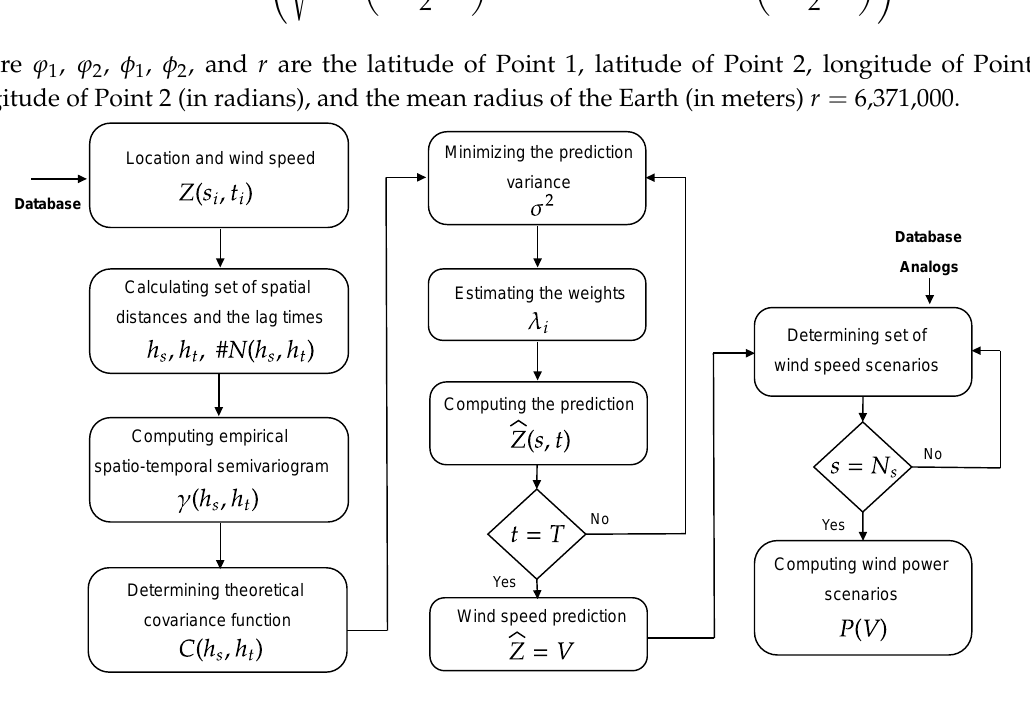
Figure 1. Solution methodology flowchart.